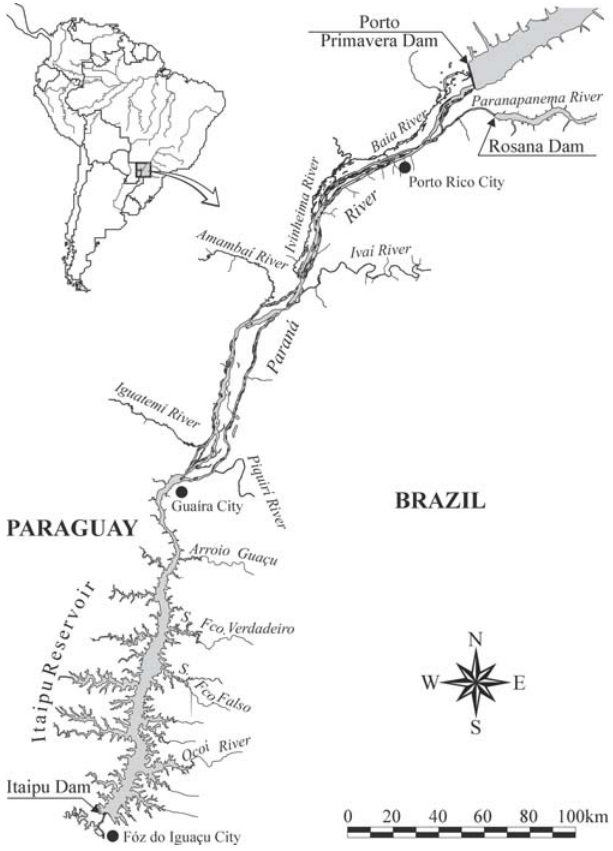
Fig. 1. Itaipu Reservoir, its tributaries and the upper Paraná River Floodplain upstream (spawning areas for the reservoir migratory fish